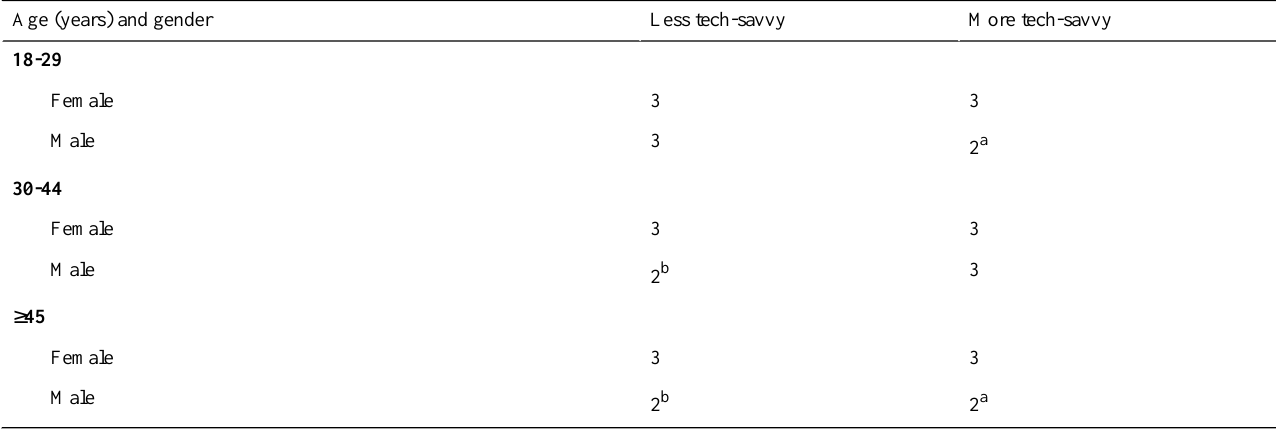
Table 1. Participants by recruitment